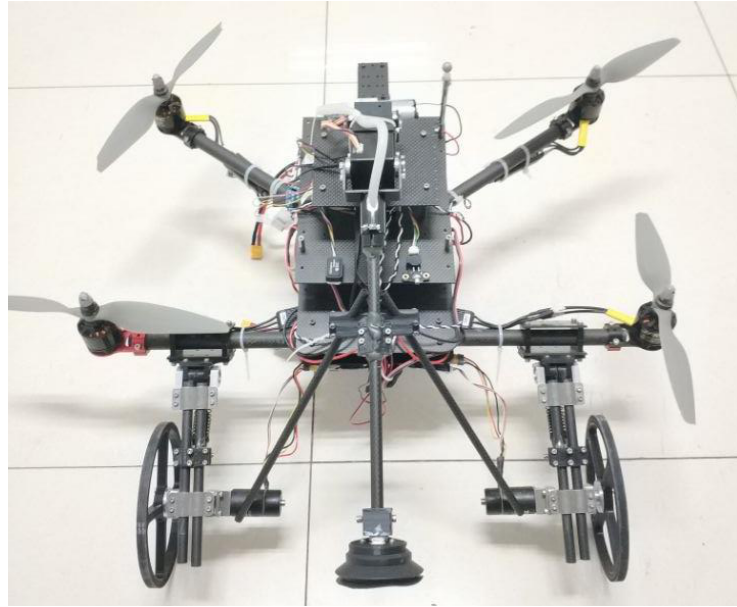
Figure 14. Robot platform (LAWCDR).